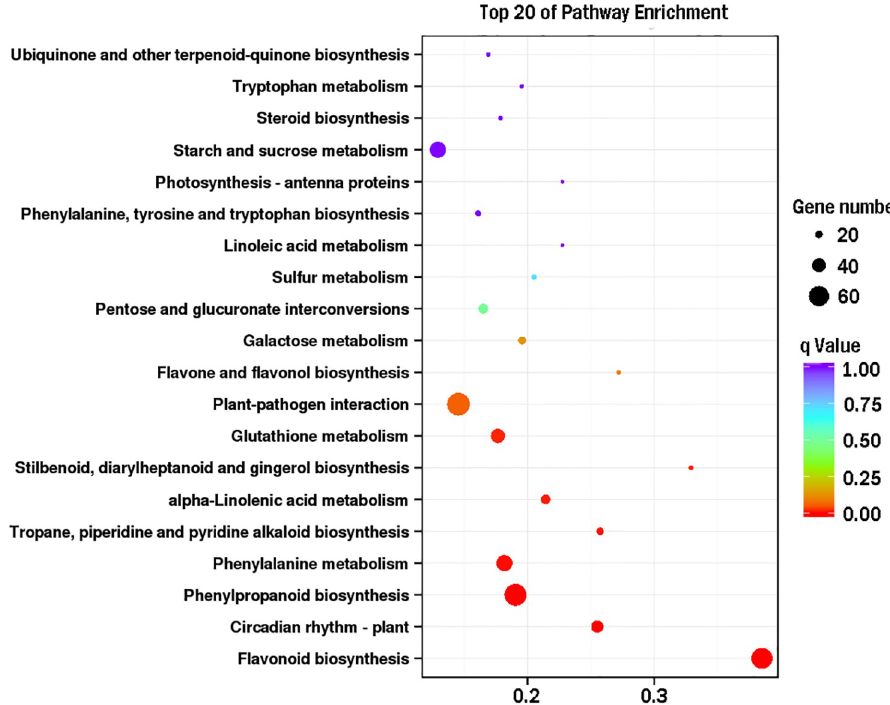
Fig 5. Relative abundance and distribution of the top 20 TF families between ‘Red Globe’ and ‘Muscat Hamburg’ at three developmental stages among the DEGs.